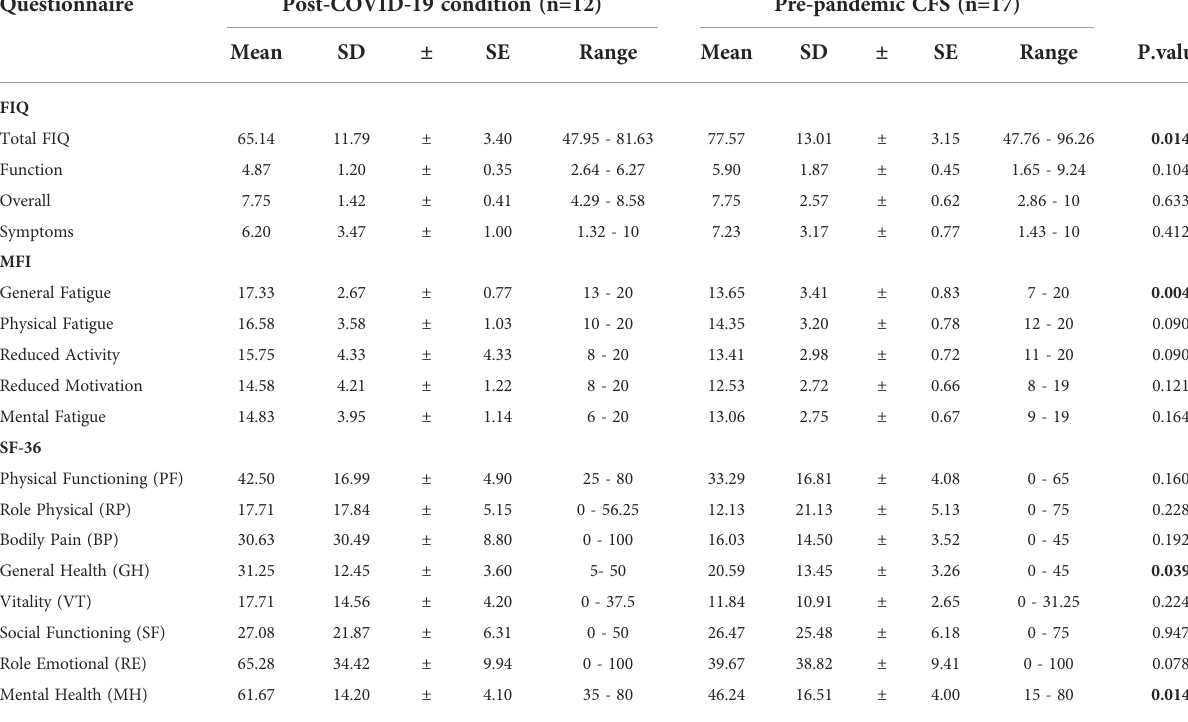
FIQ,FibromyalgiaImpactQuestionnaire;MFI,MultiFatigueInventory;SF-36,Short-Form-36HealthSurvey;SD,standarddeviation;SE,standarderror.Rangereferstothepossiblevaluesinthe studied group. Statistical tests: t-test for variables with normal distribution and equal variances or Mann-Whitney for variables not normally distributed. Bold numbers indicate signi fi cant differences between the two patient groups